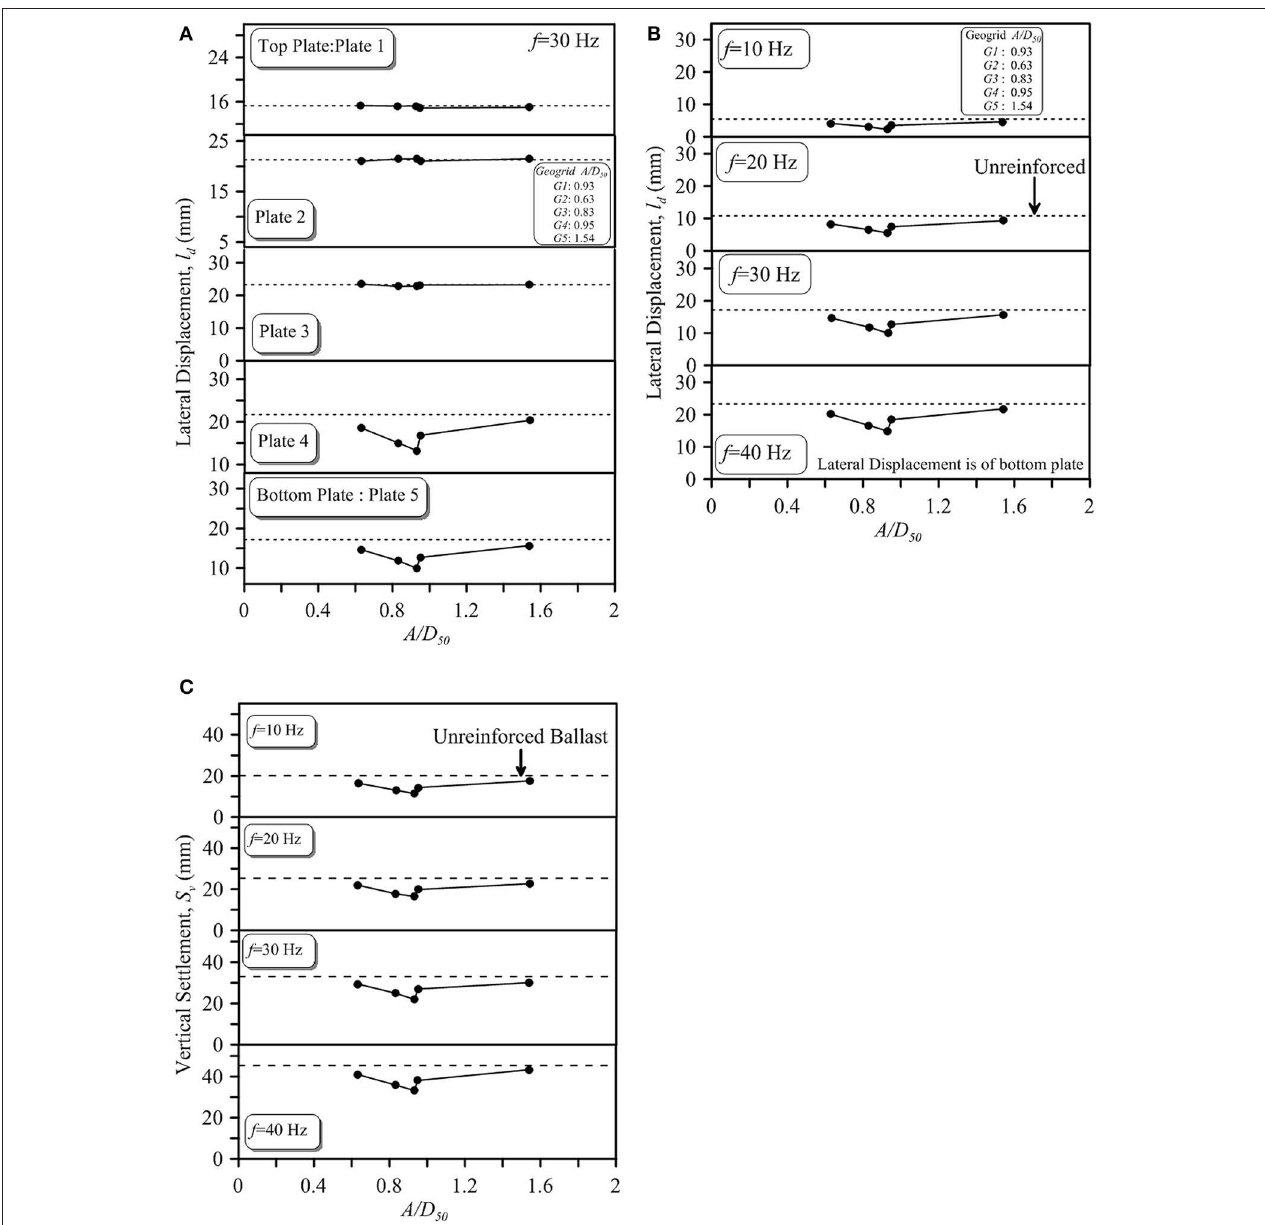
FIGURE 8 | Variation of (A) lateral displacement ( l d ) of geogrid-reinforced ballast with A/D 50 at f = 30Hz, (B) lateral displacement ( l d ) with A/D 50 at different frequencies, and (C) vertical settlement with A/D 50 at different